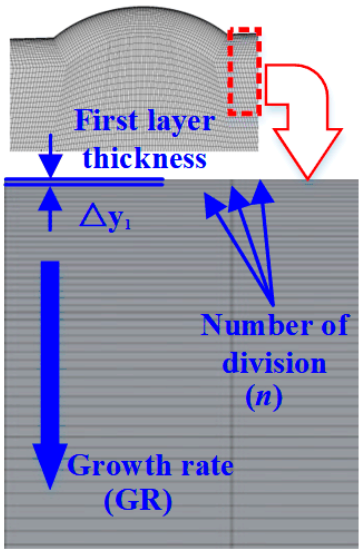
Figure 4. Grid parameters. Figure 5 shows the effects of mesh sizes on the distribution of the Nusselt number and pressure difference through a dimpled channel. We conduct to the mesh independency test for hemispherical dimpled channel at R e = 12,000, and analyze the effect of five different grid densities of the channel on Nusselt value and pressure difference. The five configurations have grid layout with approximately 4682, 5325, 9634, 20,488, and 28,320 cells, respectively. When the grid number increases from 9634 to 28,320, the Nusselt number decreases from 322.4 to 323.13, and the pressure difference increases from 2227.6 Pa to 2218.6 Pa. It is clearly visible that after 20,488 further increasing the grid number causes negligible variations in local Nusselt number and pressure difference values on the dimpled channel region.